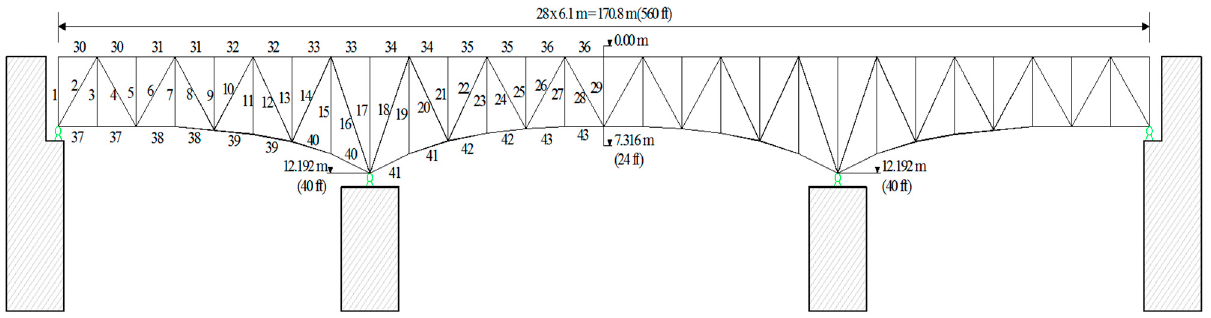
Figure 18. Layout and geometry of the 113-bar planar truss bridge.